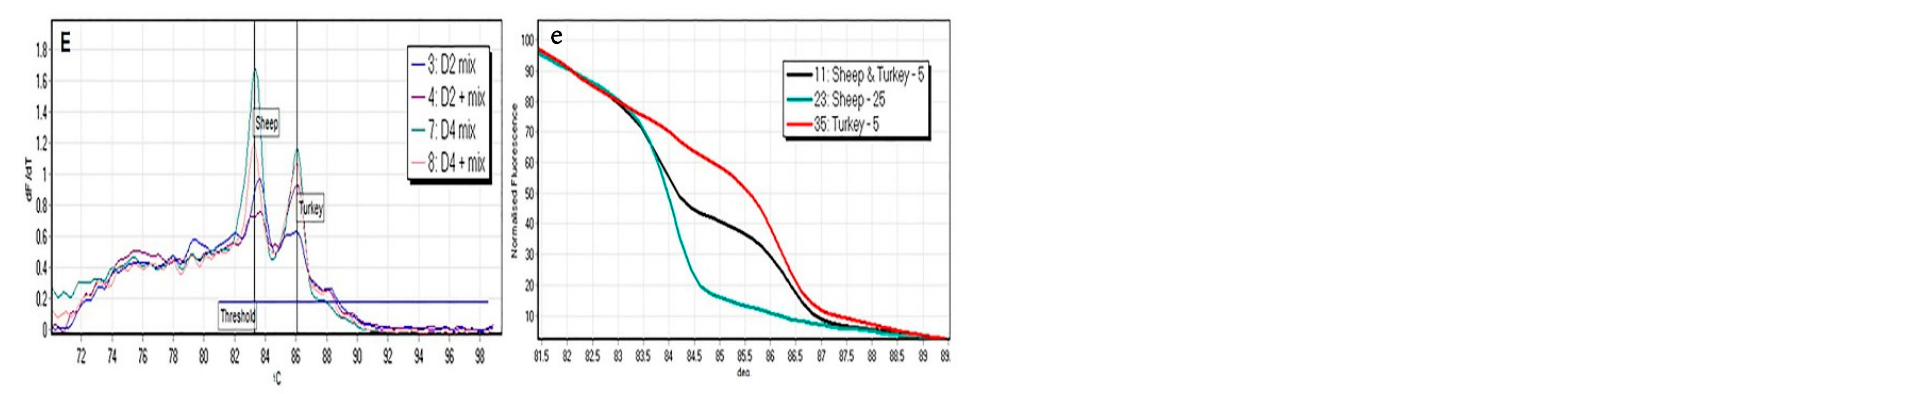
Figure 2. Two distinct melting curves with specific Tm, indicating the presence of two types of meat in the mixed meat samples. ( A ) Sheep and cattle—peak 1: 83 ◦ C for sheep and peak 2: 85 ◦ C for cattle. ( B ) Cattle and chicken—peak 1: 84.5 ◦ C for cattle and peak 2: 87.6 ◦ C for chicken. ( C ) Cattle and turkey—peak 1: 84.5 ◦ C for cattle and peak 2: 85.6 ◦ C for turkey. ( D ) Sheep and chicken—peak 1: 83.5 ◦ C for sheep and peak 2: 87.8 ◦ C for chicken. ( E ) Sheep and turkey—peak 1: 83.3 ◦ C for sheep and peak 2: 86 ◦ C for turkey. ( F ) Pig and chicken—peak 1: 84.4 ◦ C for pig and peak 2: 88 ◦ C for chicken. ( G ) Pig and turkey—peak 1: 84.1 ◦ C for pig and peak 2: 85.9 ◦ C for turkey. ( H ) Cattle and pig—a main peak with a mild shoulder at 84.1 ◦ C was observed in a mixture sample of cattle and pig. ( I ) Sheep and pig—peak 1: 83.4 ◦ C for sheep and peak 2: 84.6 ◦ C for pig. (a) to (i) illustrate HRM plots demonstrating two temperature shifts related to each species-specific meat